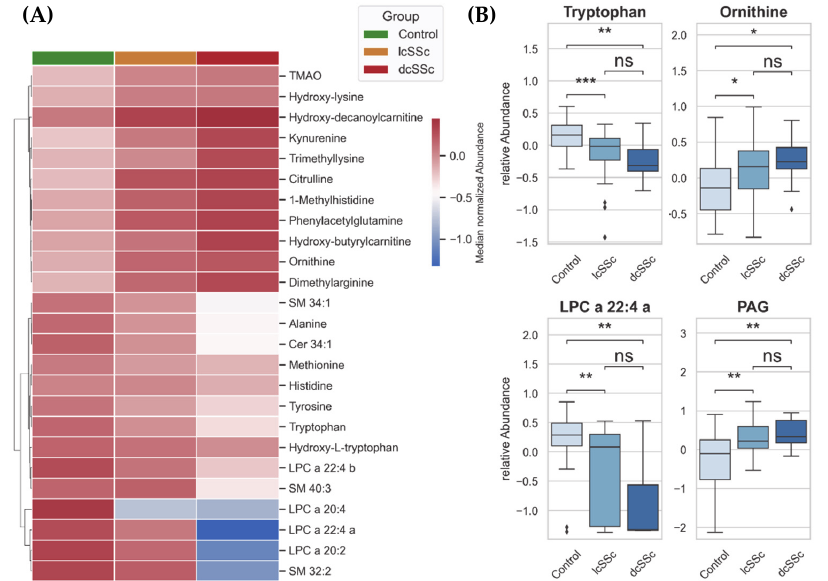
Figure 2. ( A ) Hierarchical heatmap showing a gradient of metabolites from plasma of control group, patients with limited cutaneous SSc and patients with diffuse cutaneous SSc. Distance measure: Euclidean, Clustering-Algorithm: Ward. ( B ) Box Plots (Box = IQR, whiskers = 1.5 × IQR, horizontal bars = median) of significantly changed metabolites: tryptophan, ornithine, LPC = lysophosphatidylcholine, and PAG = phenylacetylglutamine. p -values were determined using a two-tailed Student’s t -test; p < 0.05 was considered significant (* p < 0.05, ** p < 0.01, *** p < 0.001, ns: not significant).